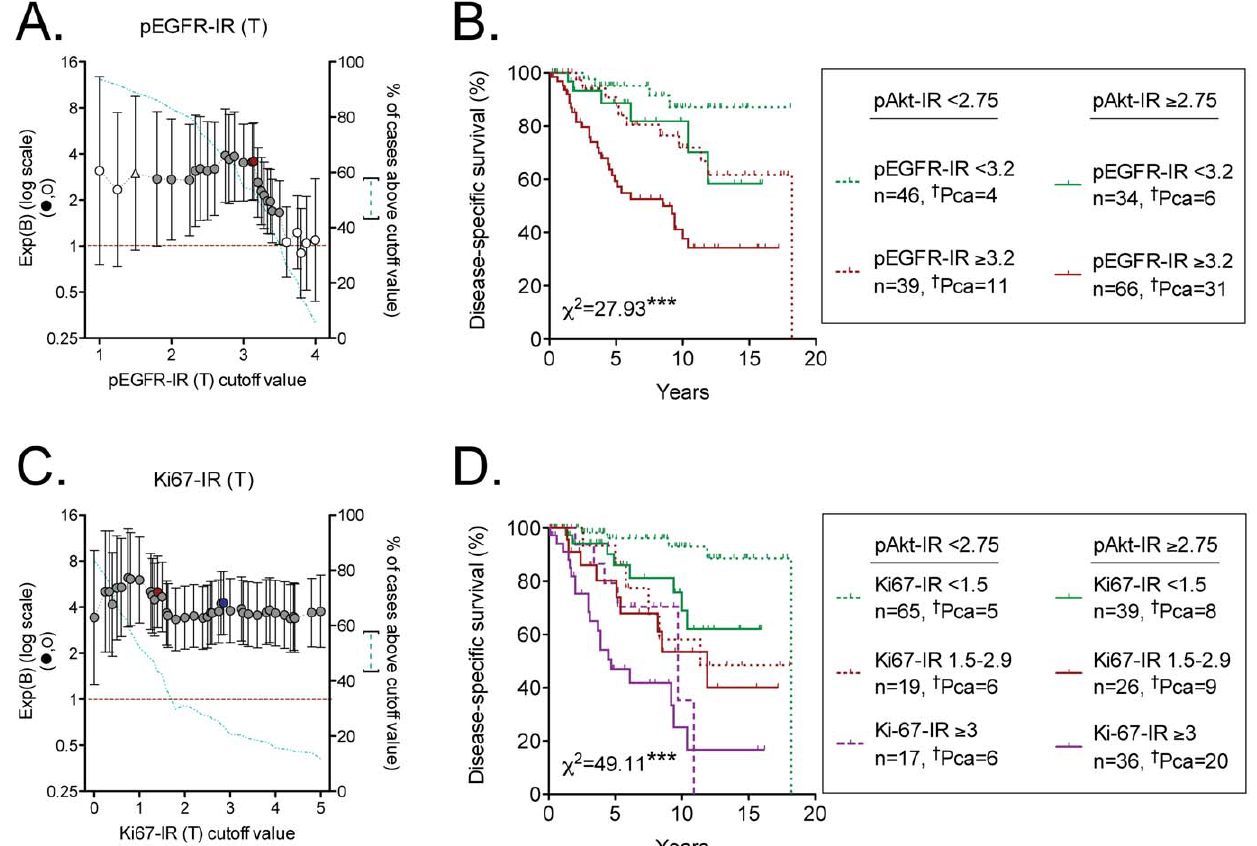
Figure 3. Prognostic significance of tumour pEGFR-IR and Ki67-IR for cases who were followed by expectancy: relationship with tumour pAkt-IR. Panel A shows Exp(B) obtained from Cox proportional-hazards regression analyses are shown for different cut-offs of pEGFR-IR (n=253). The cut-off value with the highest significance is shown as a red filled symbol. Values with a significance level 0.05 , P , 0.1 are shown as open triangles. Panel B shows a Kaplan-Meier plot for the 185 cases scored for both tumour pAkt-IR and pEGFR-IR, divided up on the basis of their optimal cut-offs. In Panel C, Exp(B) values are shown for different cut-offs of Ki67-IR (n=286). The red and blue symbols indicate the highest significance levels for the lower range and for the higher range, respectively. Panel D shows a Kaplan-Meier plot for the 202 cases scored for both tumour pAkt-IR and Ki67-IR, divided up on the basis of their optimal cut-offs. { Pca refers to the number of patients who died as a result of their prostate cancer during the follow-up period. The k¸ 2 values are for the log-rank (Mantel-Cox) tests, with the P values shown: ***P , 0.001.